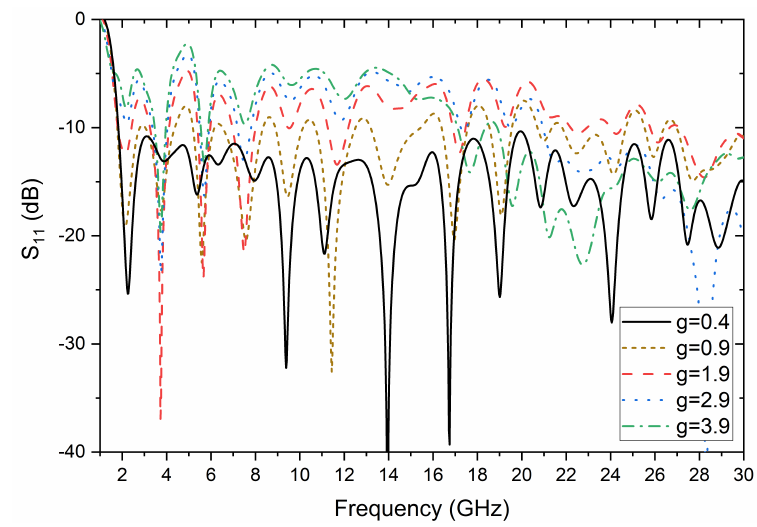
Figure 5. The simulated reflection coefficients for different values of distance g .